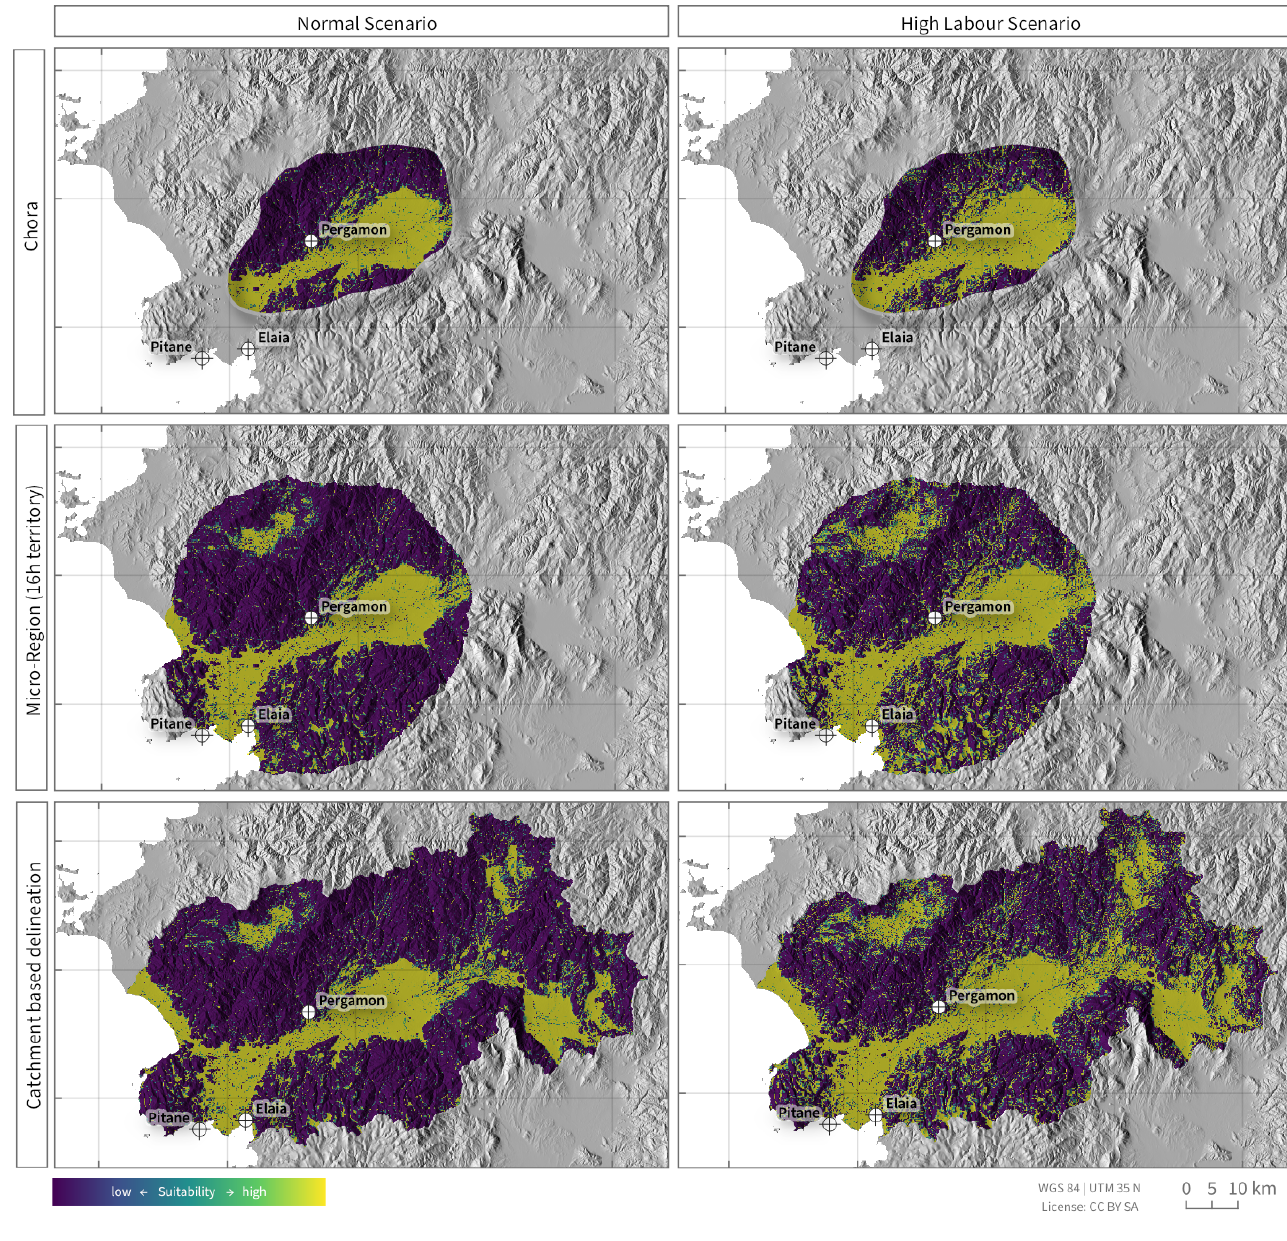
Figure 3. Maps of the suitability for certain